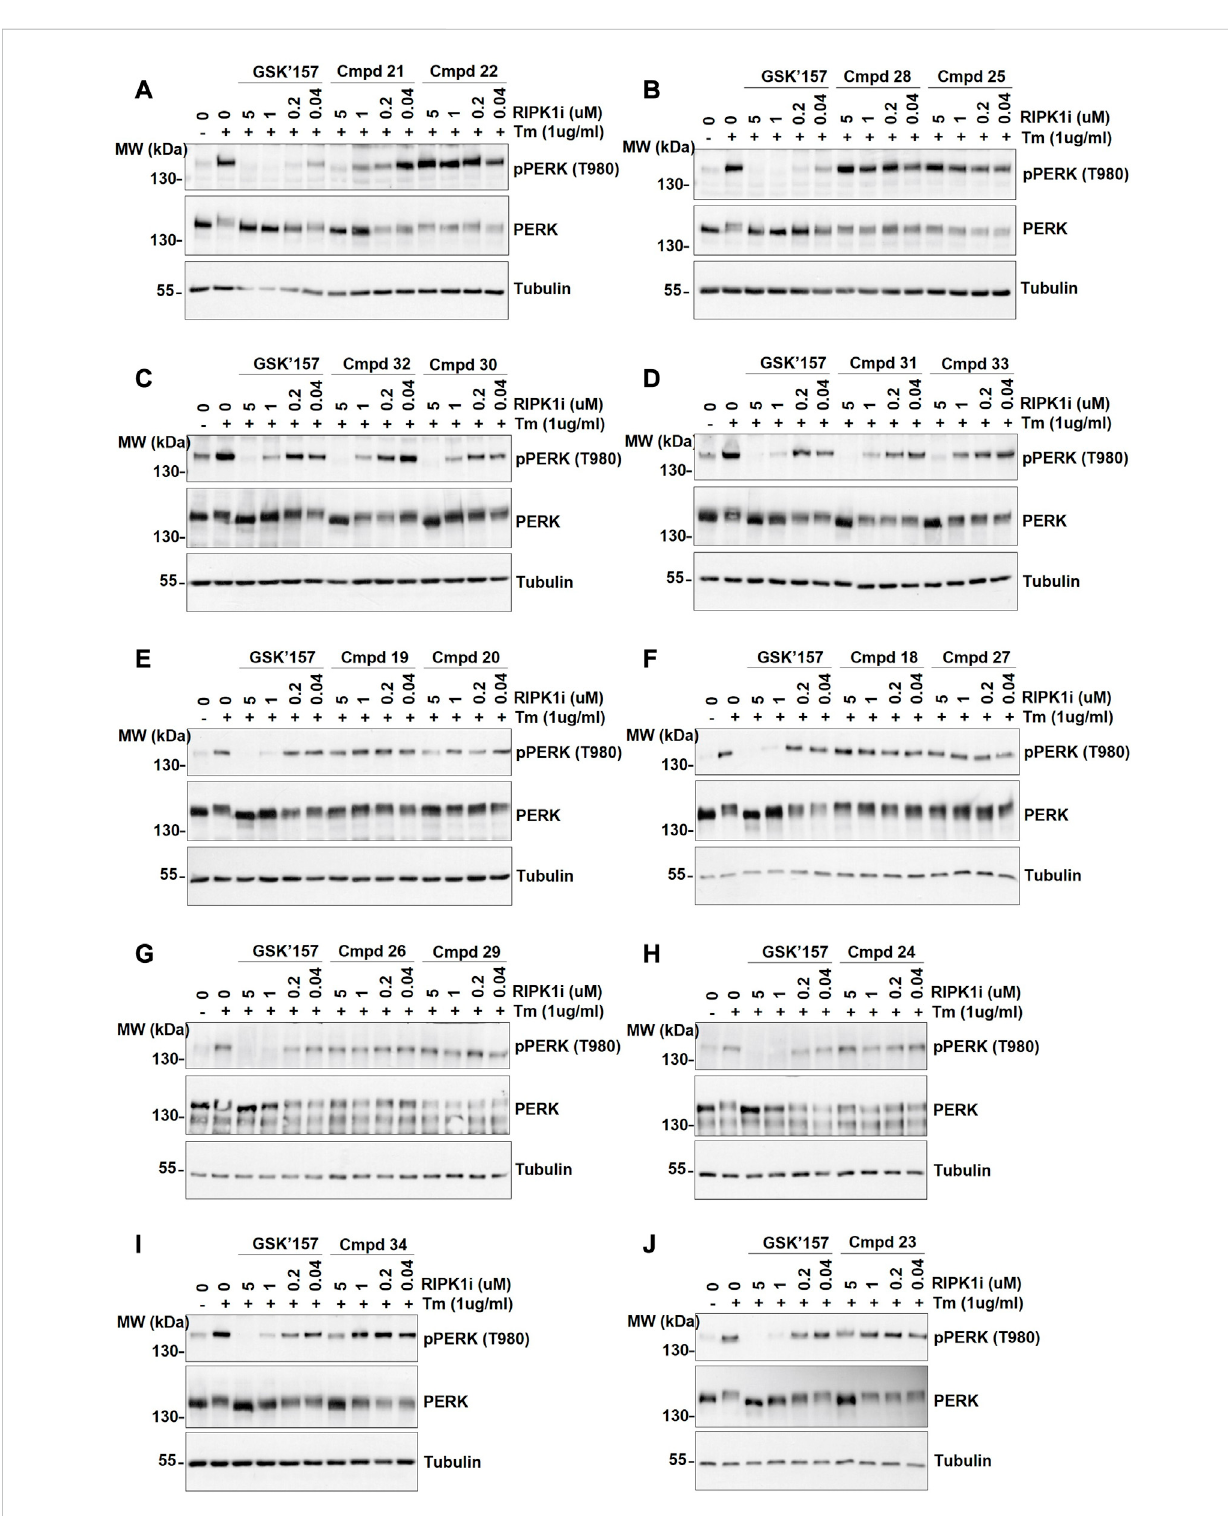
FIGURE 5 The effect of GSK ’ 157 in comparison with compounds (cmpd) 18 – 34 on PERK autophosphorylation is reported in fi gures (A – J) . Immortalized MEFs were pretreated for 30 min with increasing concentrations ofGSK ’ 157 and the indicated compounds and stimulated with tunicamycin (Tm) (1 μ g/mL) for 4 h. The cell lysates were then immunoblotted as